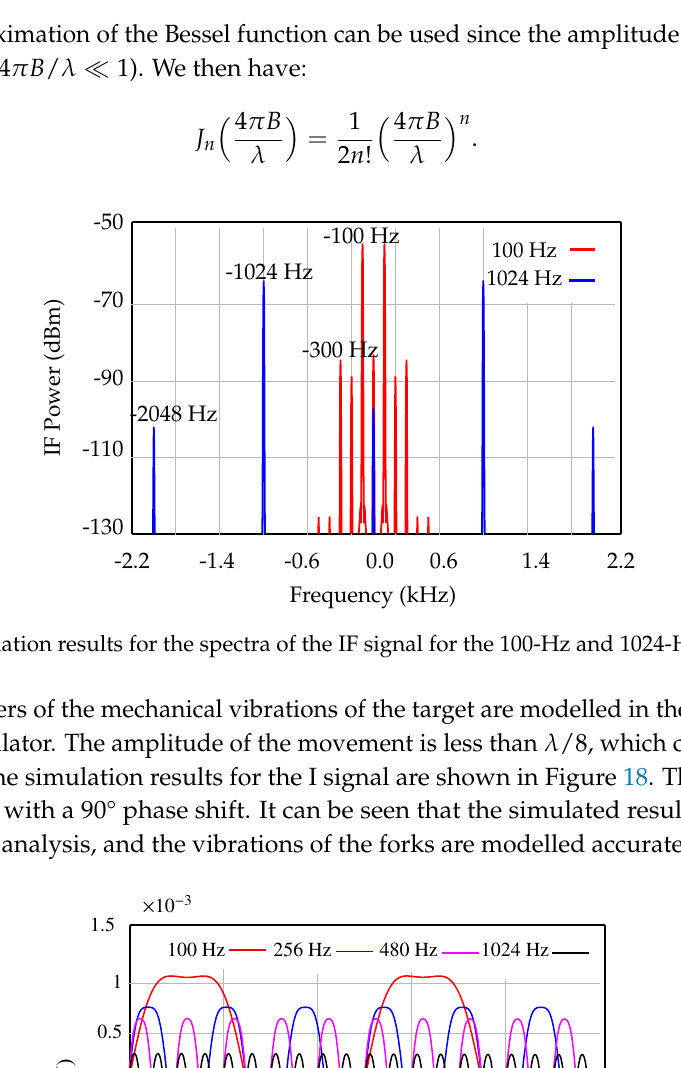
Figure 18. Magnitude of the IF signals (I). 4.2. System Measurement Results Measurements are performed with our fabricated prototype. Its picture is shown in Figure 19a. The measurement set-up includes the HP-83550 series mm-wave source, the mm-wave active